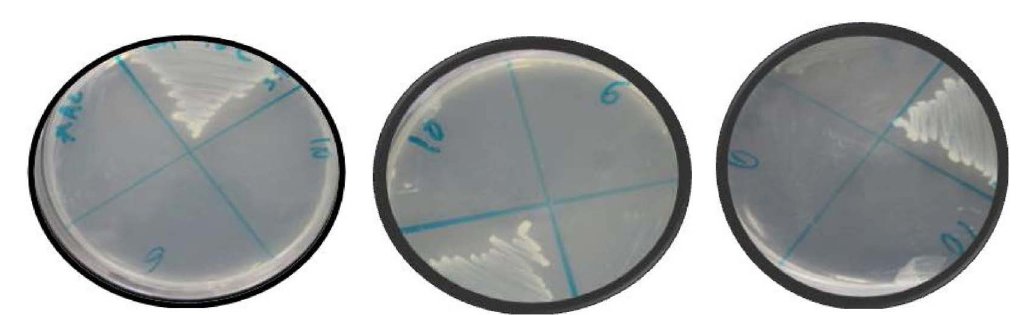
after plasmid curing. 2